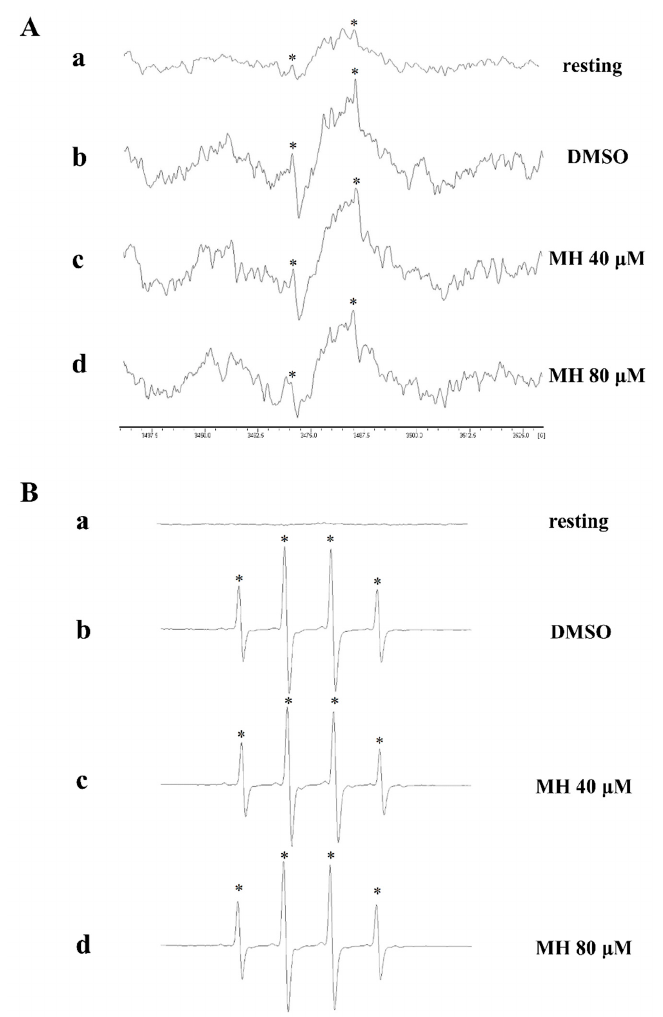
Figure 5. Activities of morin hydrate on OH · formation in human platelet suspensions or the Fenton reaction solution. ( A ) Washed platelet suspensions or ( B ) the Fenton reaction solution was preincubated with (a) Tyrode’s solution (resting control), (b) 0.1% DMSO, or morin hydrate at (c) 40 µ M or (d) 80 µ M. Collagen (1 µ g/mL) was then added for the Electron Spin Resonance (ESR) experiments, as described in Materials and Methods. Profiles are representative of four independent experiments, and an asterisk (*) indicates OH ·